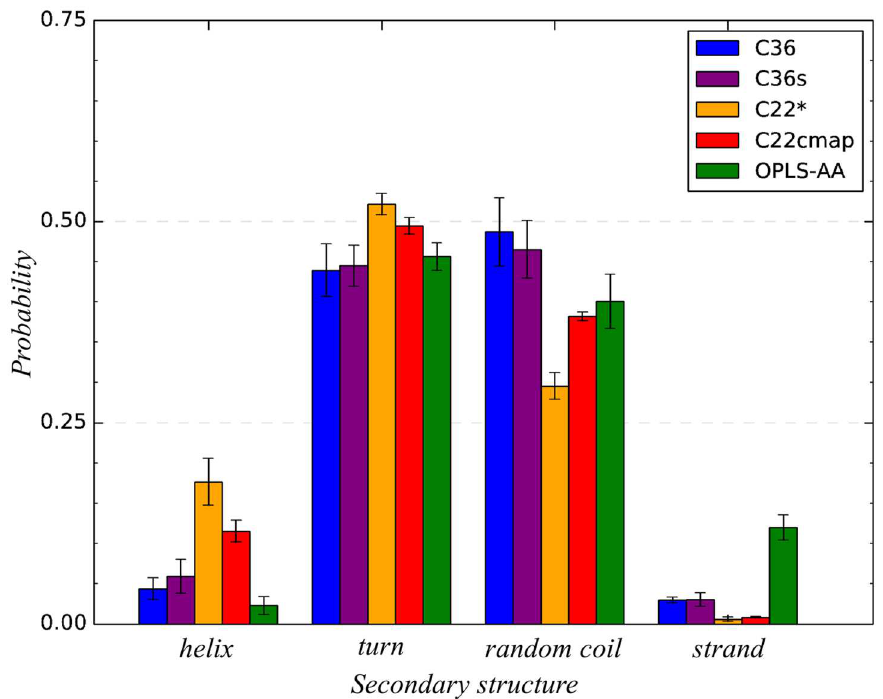
Fig 2. A β 10-40secondary structure in different force fields. Total fractions of helix, turn, random coil, and β secondary structures for each of the five force fields probedin REMD simulations. All force fields predict dominance of turn and randomcoil conformations. C22 * and OPLS-AA reveal moderate helix and β -structure propensities, respectively.